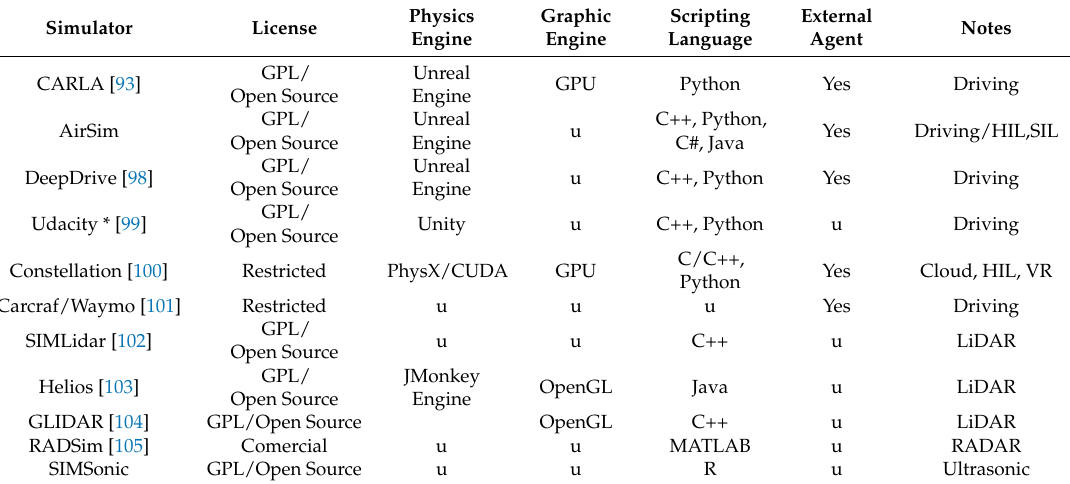
* Table Legend: u–Unknown or could not be determined.